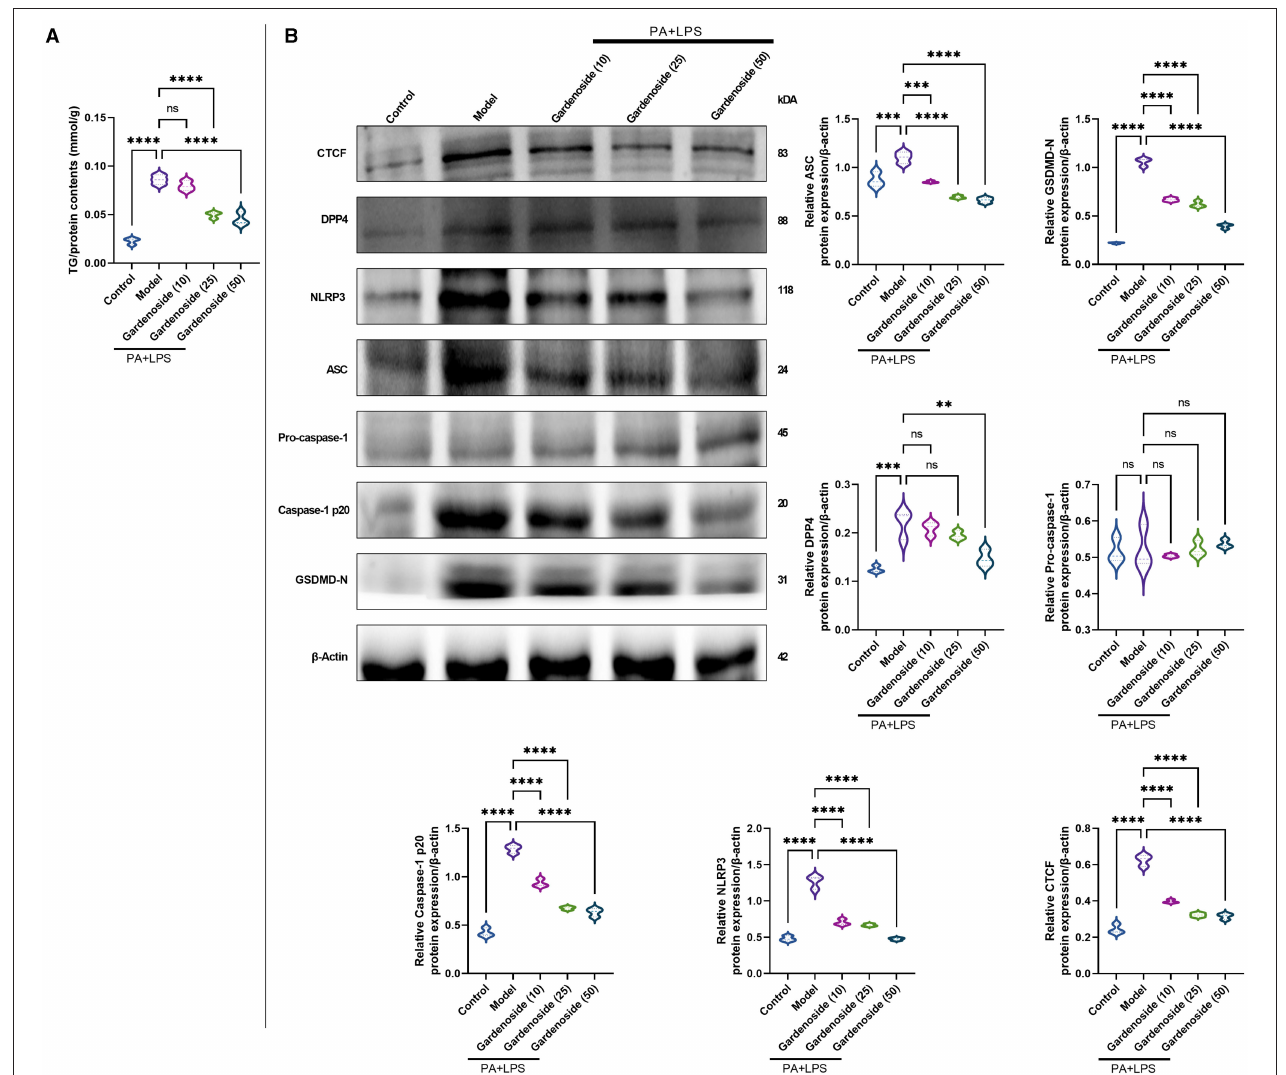
FIGURE 2 | Gardenoside reduced the accumulation of lipid and pyrin-domain containing 3 (NLRP3) inflammasome and pyroptosis-associated proteins in hepatocytes. (A) Detection of triglyceride (TG) content in alpha mouse liver (AML) cells of control, model, and gardenoside (10, 25, and 50 µ M) groups. (B) Screening of the optimal concentration of gardenoside to inhibit the activation of NLRP3 inflammasome and hepatocyte pyroptosis by Western blot. Violin plots were used to depict the relative protein expression levels of CTCF, DPP4, NLPR3, apoptosis-related speck-like protein (ASC), pro-caspase-1 p20, caspase-1 p20, GSDMD-N, pro-IL-1 β , and IL-1 β in AML cells of control, cell NAFLD model, and gardenoside (10, 25, and 50 µ M) groups by Western blot. ns, non-significant, ** p < 0.01, *** p < 0.001, and **** p < 0.0001 in the comparison between the indicated